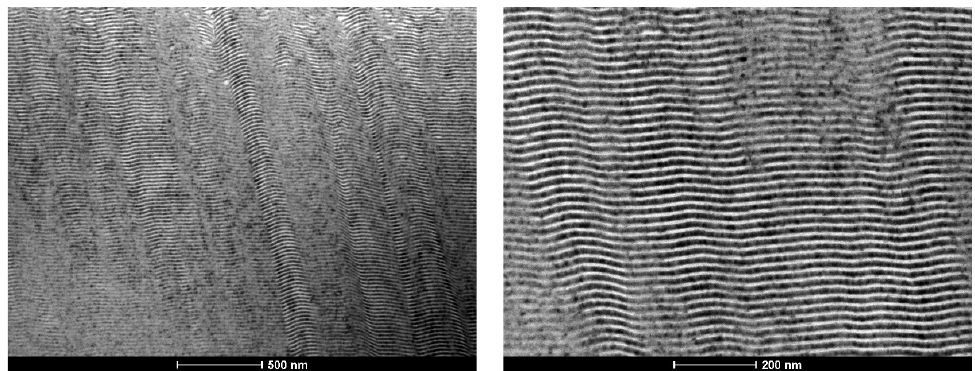
Figure 9. BF TEM cross-section micrographs of an Al/Ni thin film following ignition by mode I ( φ = 0.20 mm W wire).